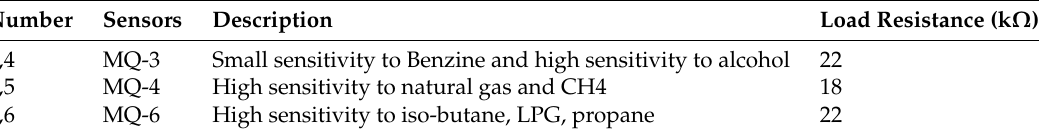
Table 3. Gas sensors array setup of dataset3.